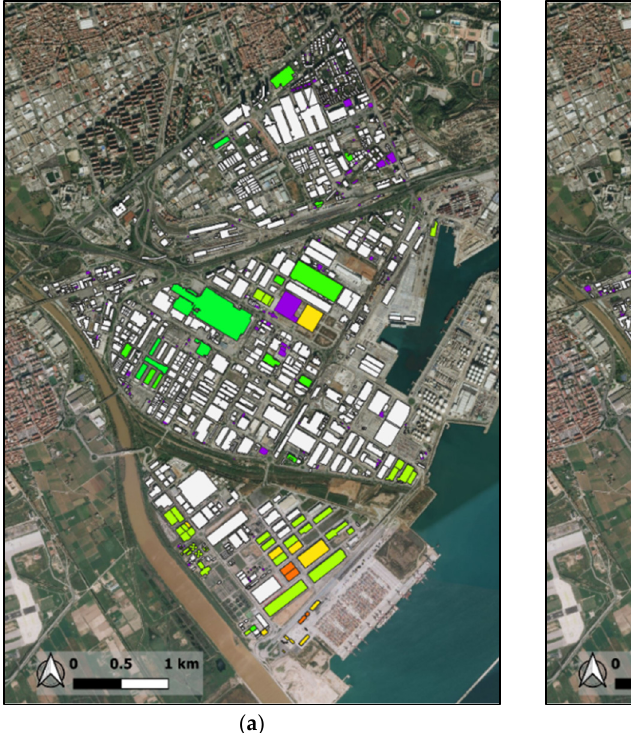
Figure 7. Maps of buildings in Zona Franca area with an average value of mean deformation velocity along ( a ) ascending and ( b ) descending orbit. The violet polygons represent buildings with lack of PSs.